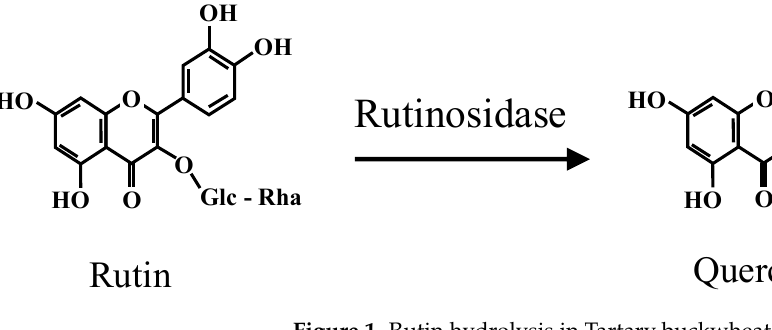
Figure 1. Rutin hydrolysis in Tartary buckwheat flour.